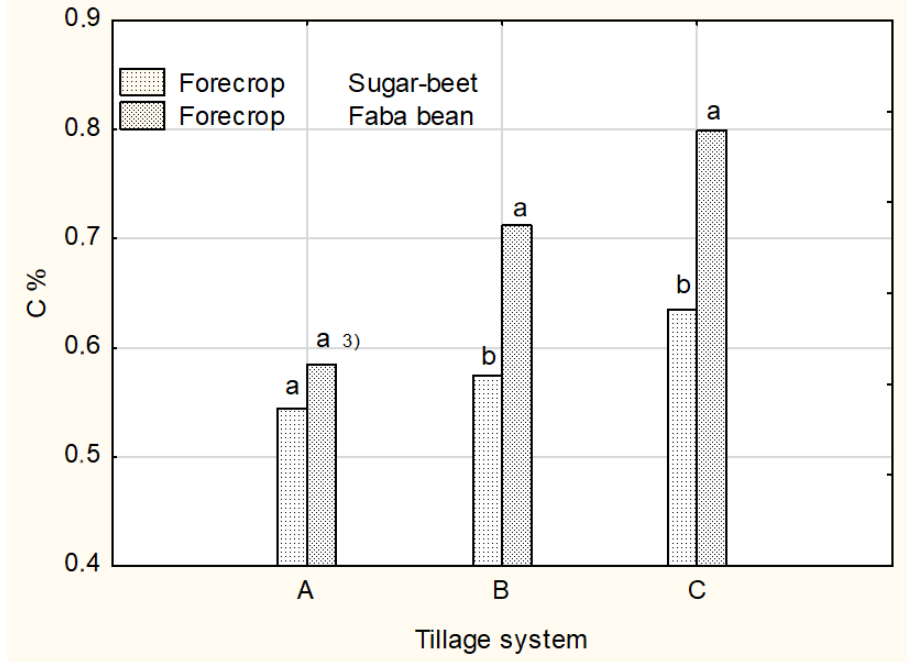
Figure 2. The effect on pre-crop on carbon content in soil depending on the tillage system, the layer at the depth 0–0.05 m. 3) a, b—means marked by the same letter do not differ significantly at the significant level < 0.05. A—ploughing; B—ploughless using cultivator and string roller; C—direct sowing.